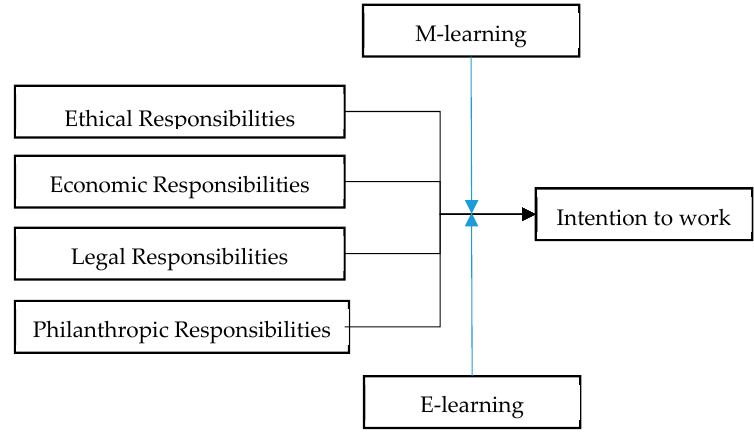
Figure 2. Conceptual model.